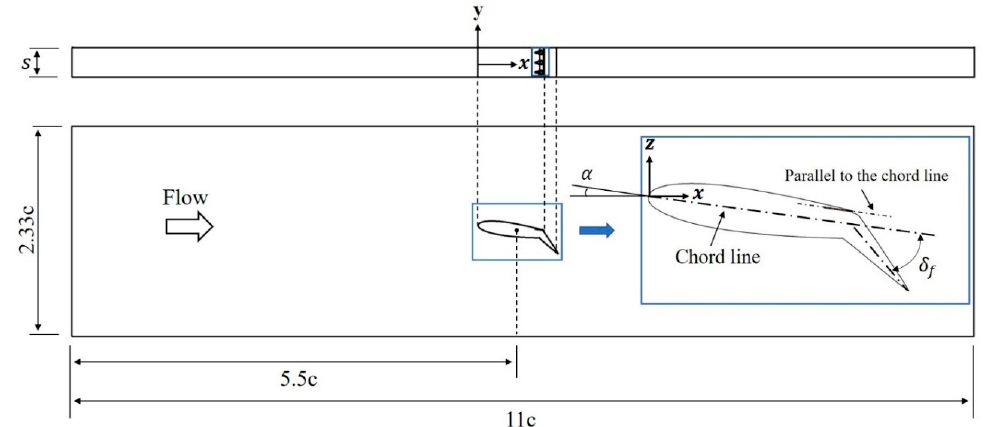
Figure 2. Computational domain for the external flow over NACA0015 airfoil with a flap and fluidic oscillators [29].